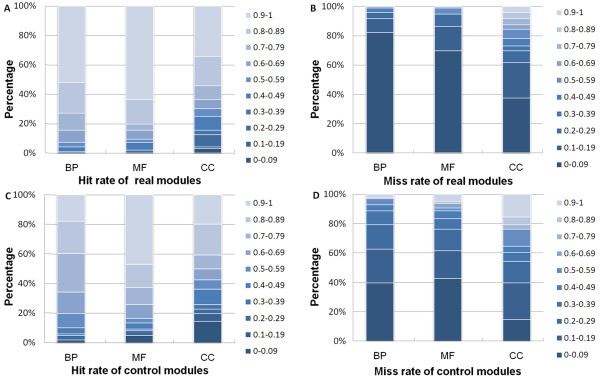
Functional consistency analysis of 96 co-regulated modules vs. random control modules (30% nodes replacement). Horizontal axis symbols represent three branches of GO (BP: biological process, MF: molecular function, CC: cellular component). Vertical axis symbols represent the corresponding percentages with different Hit-rates or Miss-rates for all modules.